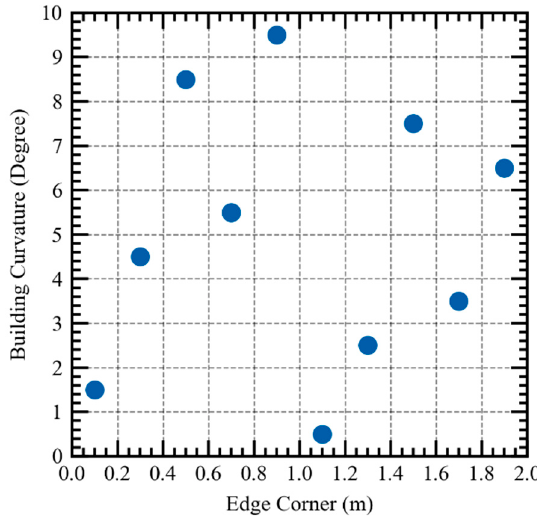
Figure 11. Sampling points.